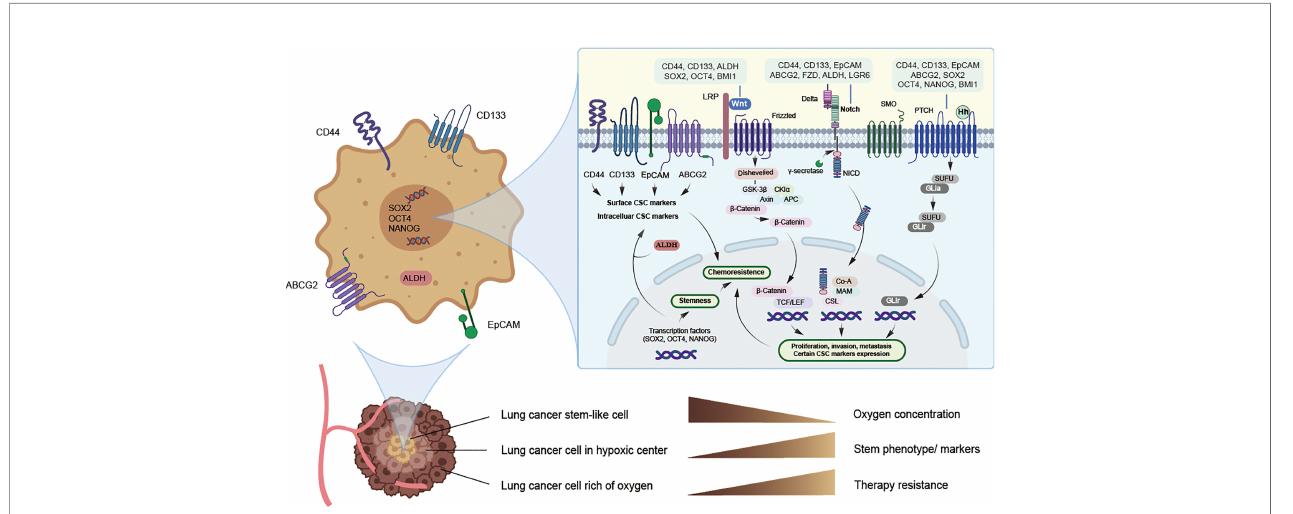
FIGURE 1 | Potential lung cancer stem cell with its markers and major signaling pathways. CSCs can live deep in the hypoxic center of tumor and hypoxia may induce CSCs phenotype and the expression of CSC markers, thus promoting chemoresistance, while speci fi c targeted therapy towards CSCs may solve this problem. Potential markers of lung cancer stem cells mainly include surface biomarkers, such as CD44, CD133, EpCAM and ABCG2, along with intracellular biomarkers, such as ALDH, SOX2, NANOG and OCT4, and they may act as promising therapeutic targets. Signaling pathways such as Notch, Hedgehog, and Wnt may jointly induce the expression of certain lung cancer stem cell markers and stimulate EMT, thus allowing tumor cells to obtain stemness and